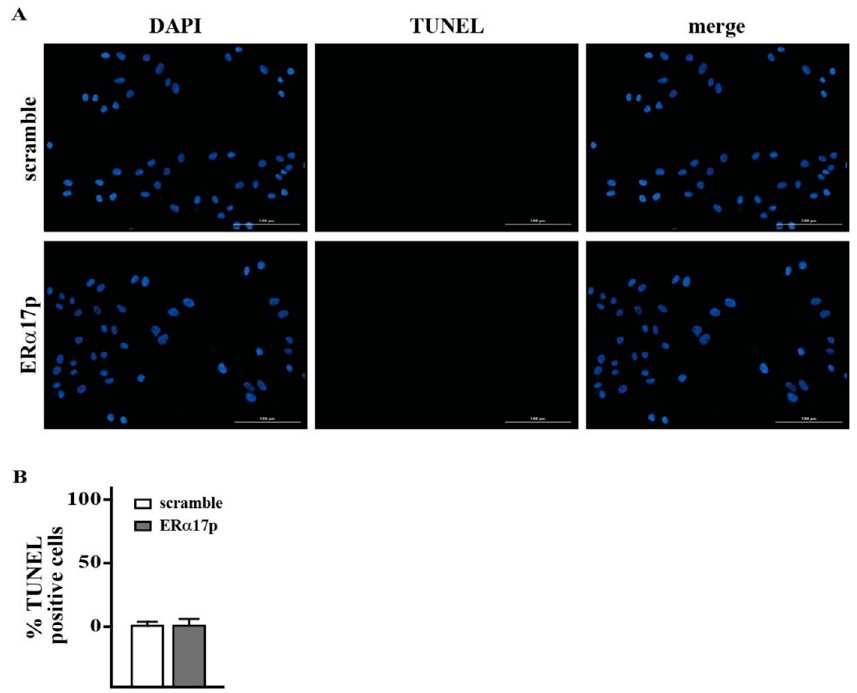
Figure 2. ( A ) Apoptosis detection by TUNEL (TdT ‐ mediated dUTP nick ‐ end ‐ labeling) assay. ( B